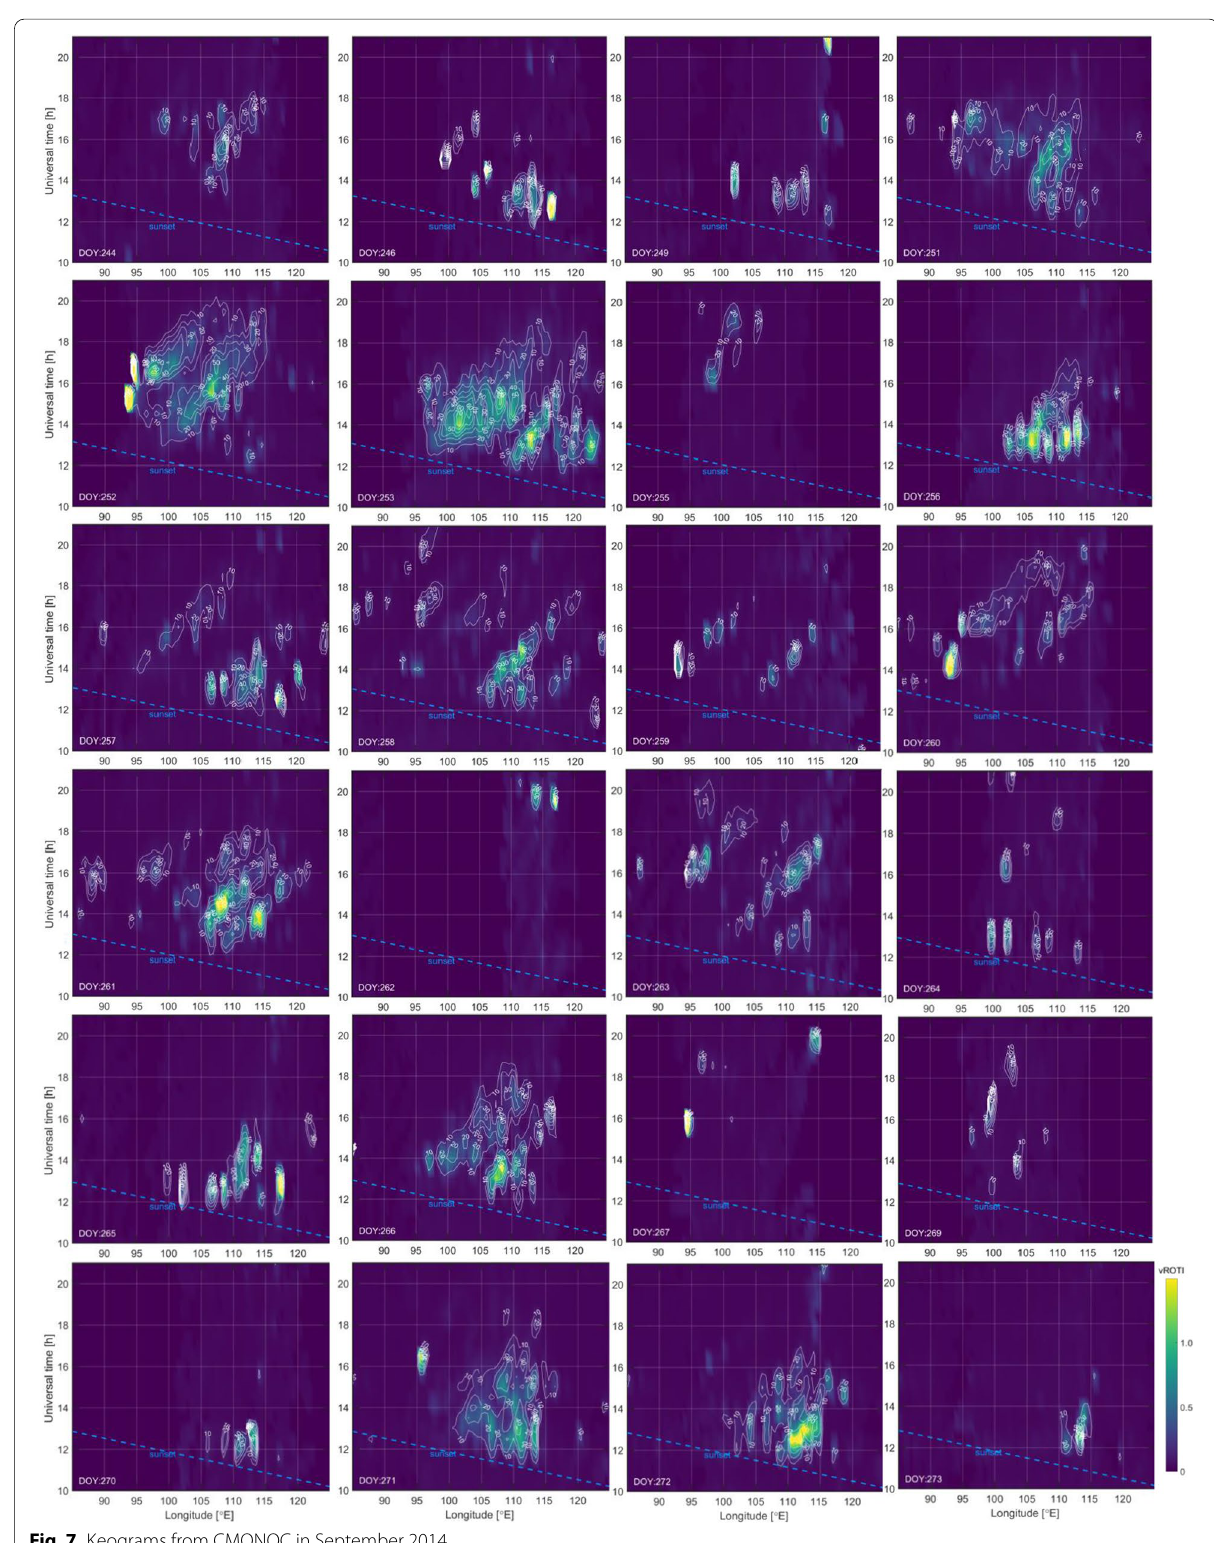
Fig. 7 Keograms from CMONOC in September